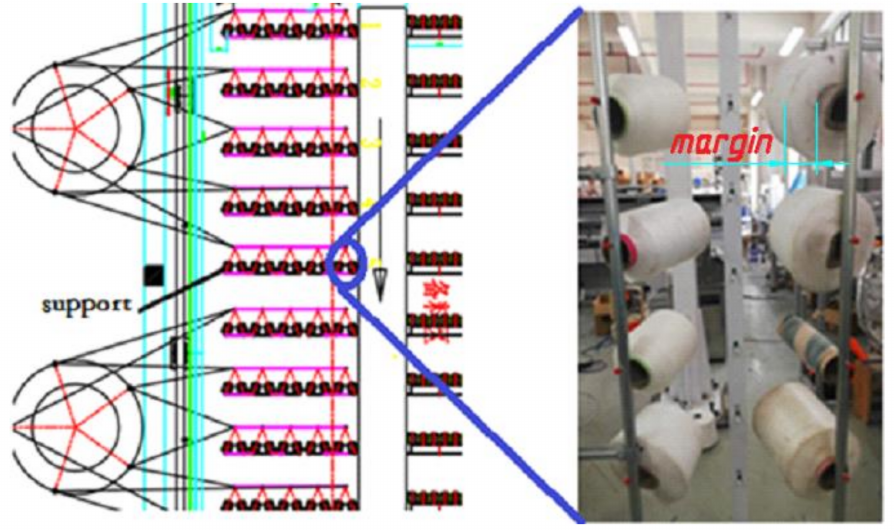
Figure 1. Supports array, there are 20 to 30 rows and every row has five supports. In every support, there are eight thread rolls distributed in two